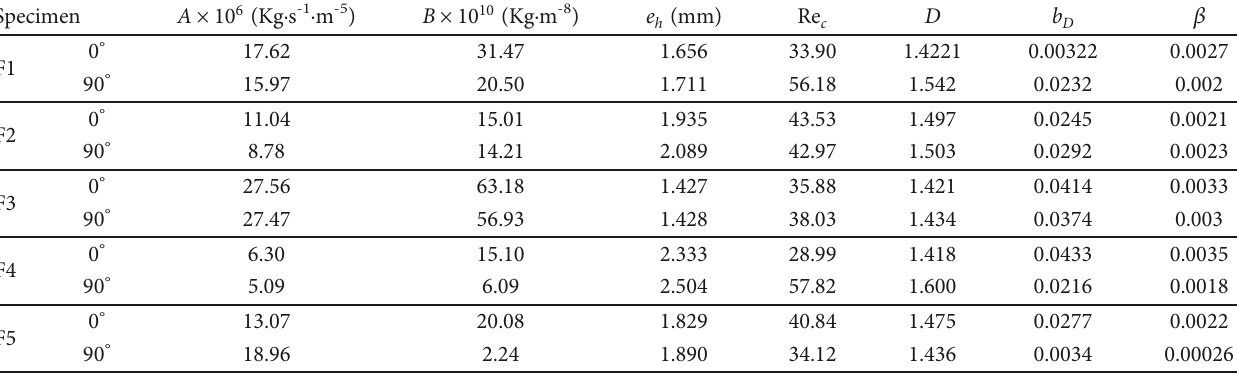
Table 3: Fractal dimension and fi tted parameters of Forchheimer ’ s law. Specimen